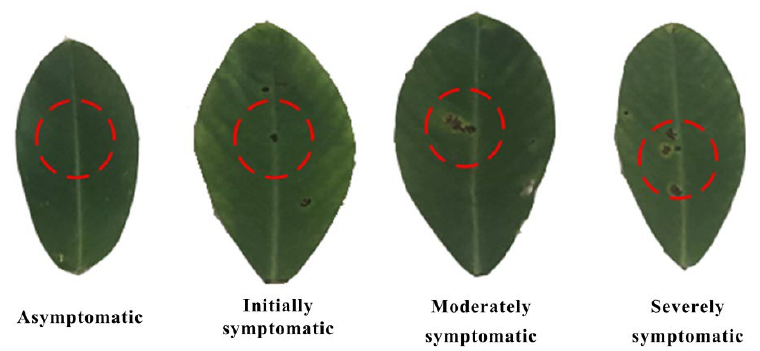
Figure 2. Leaves with different disease severity levels.